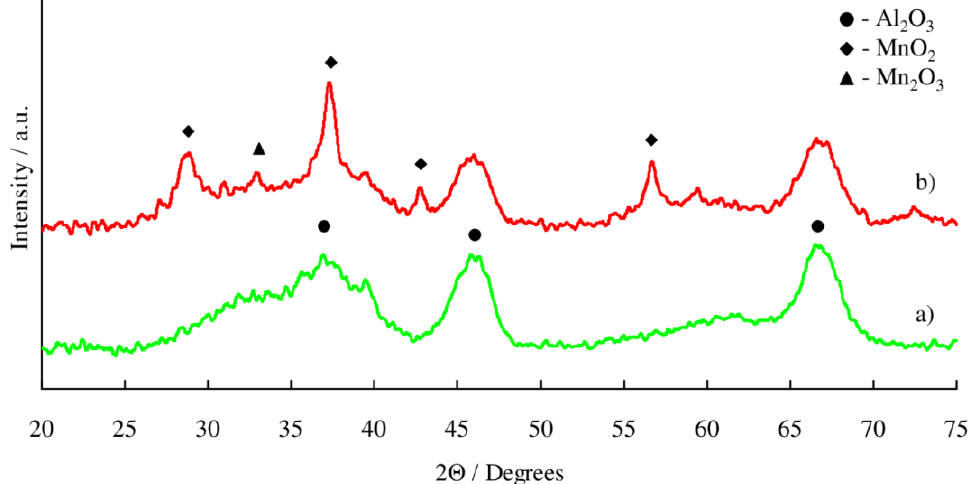
Figure 2. XRD patterns of ( a ) the parent alumina and ( b ) the Mn/Al 2 O 3 catalyst.